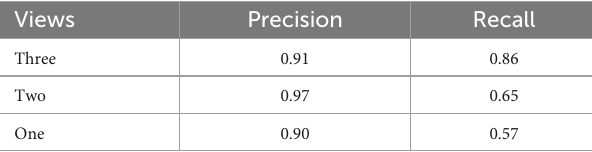
TABLE 2 Comparison of WDS recall and precision metrics with three different camera configurations in the 1 h validation recording.